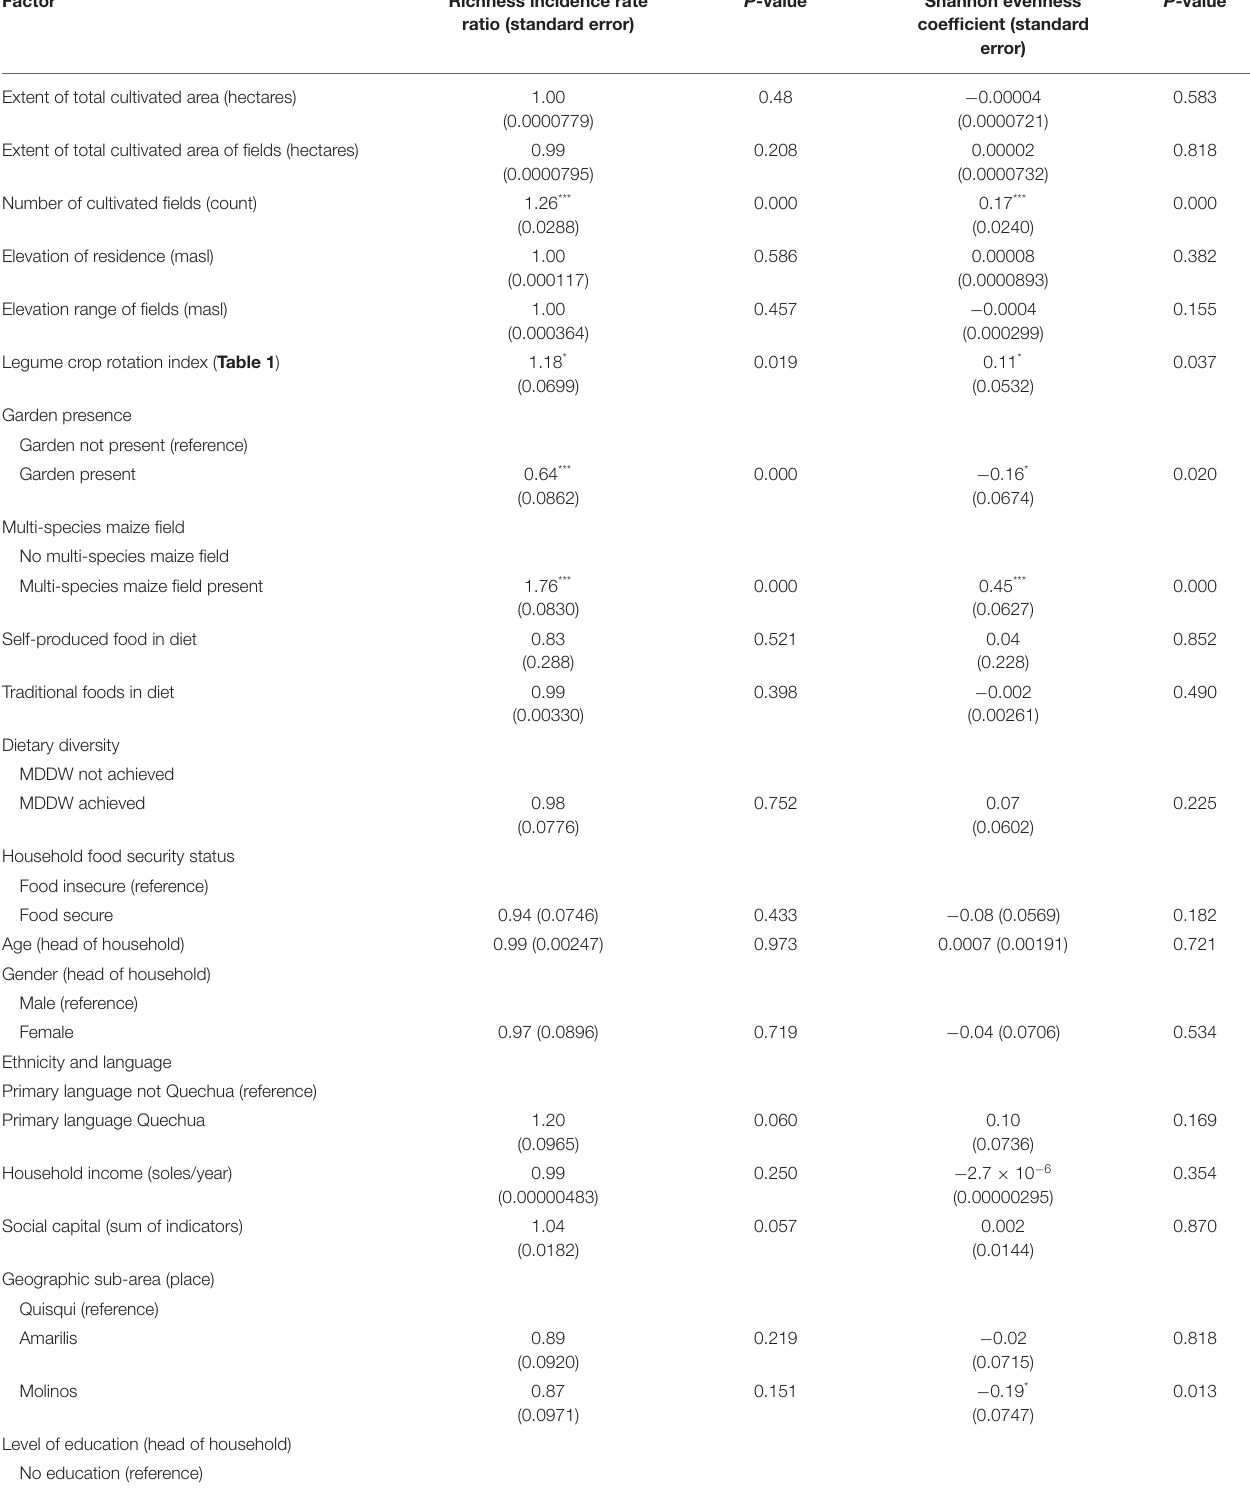
TABLE 3 | Results of multiple regression analyses of the associations of social-ecological and political-ecological factors with crop species agrobiodiversity in fields ( Chakras , Parcelas ). Factor Richness incidence rate